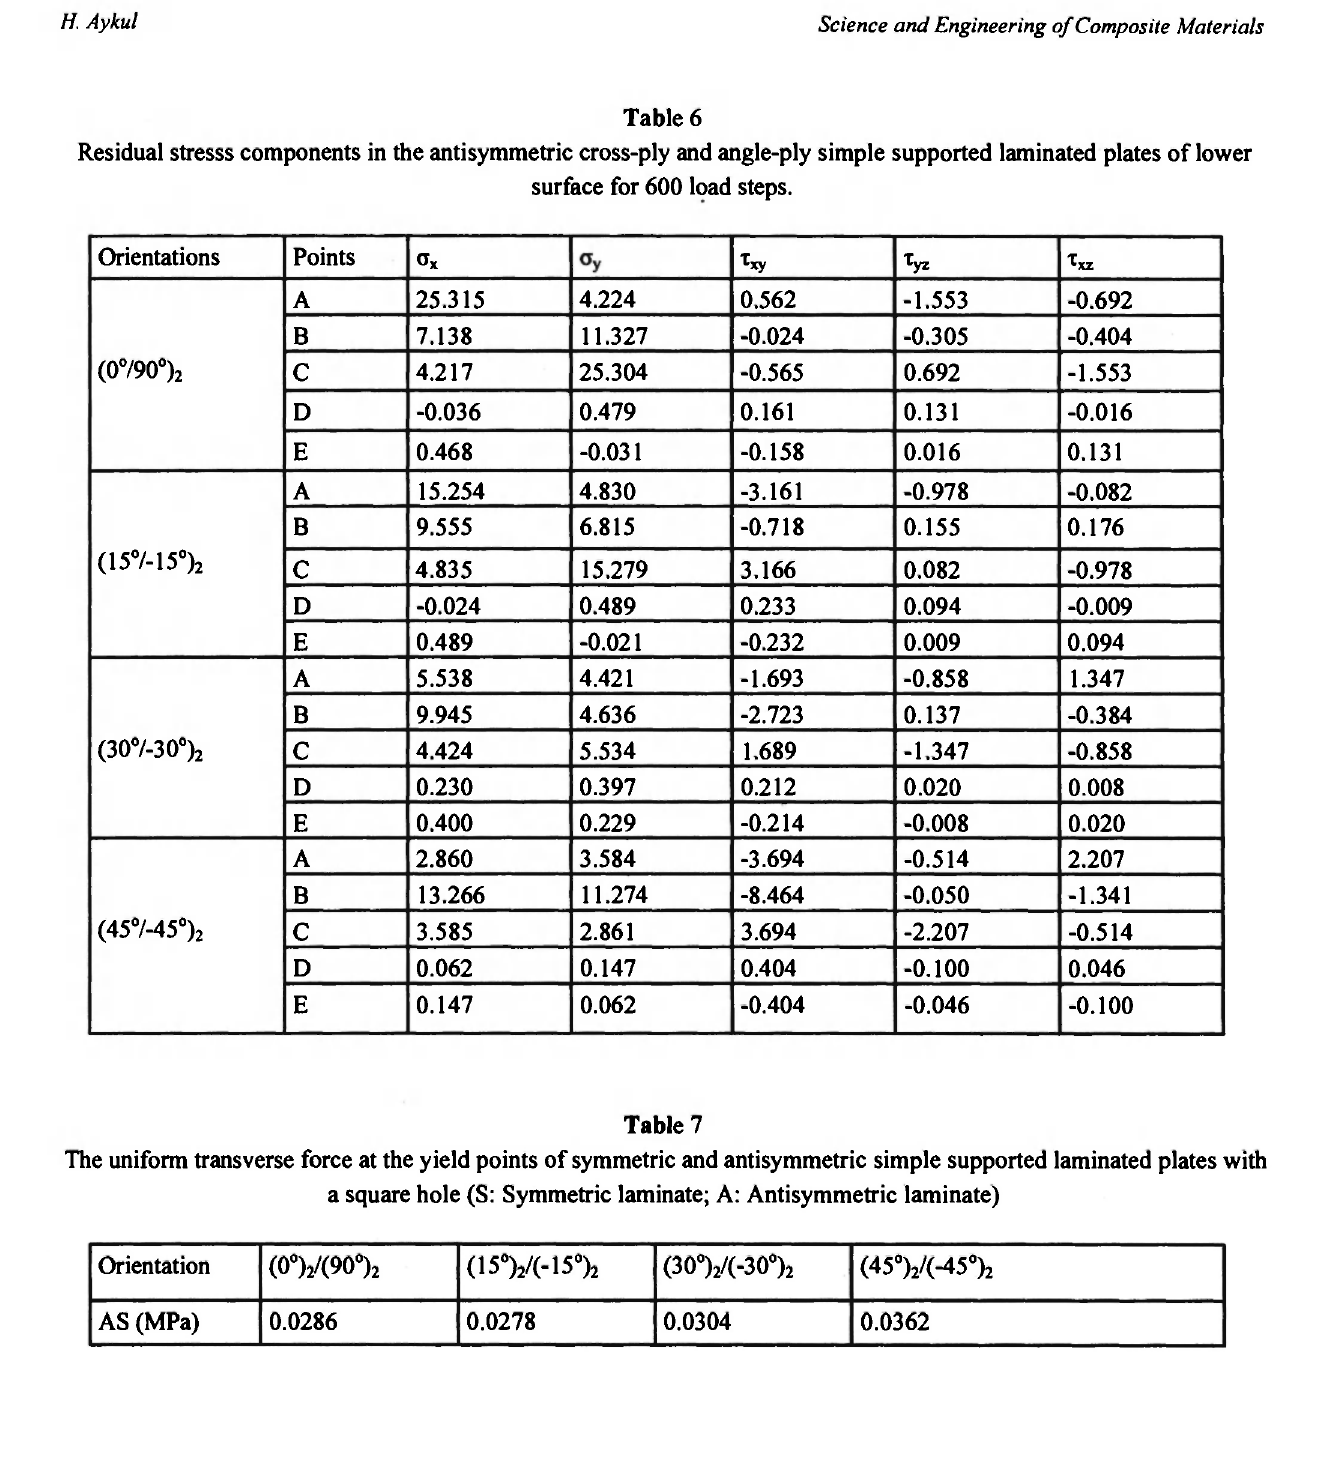
Residual stresss components in the antisymmetric cross-ply and angle-ply simple supported laminated plates of lower surface for 600 load steps.